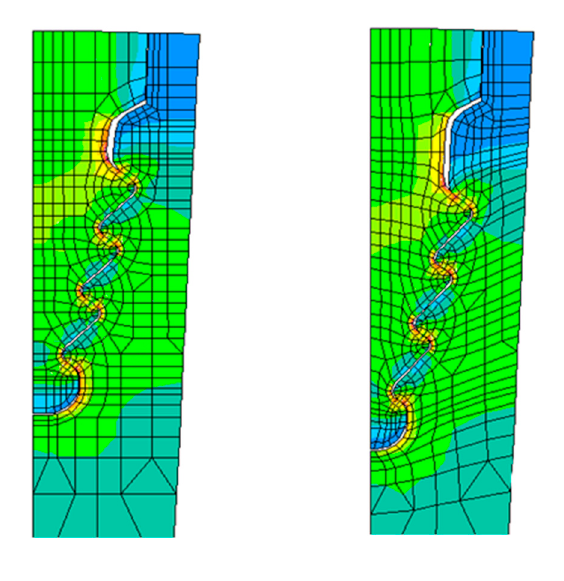
Figure 7. Shape and stress distribution of fixed part of